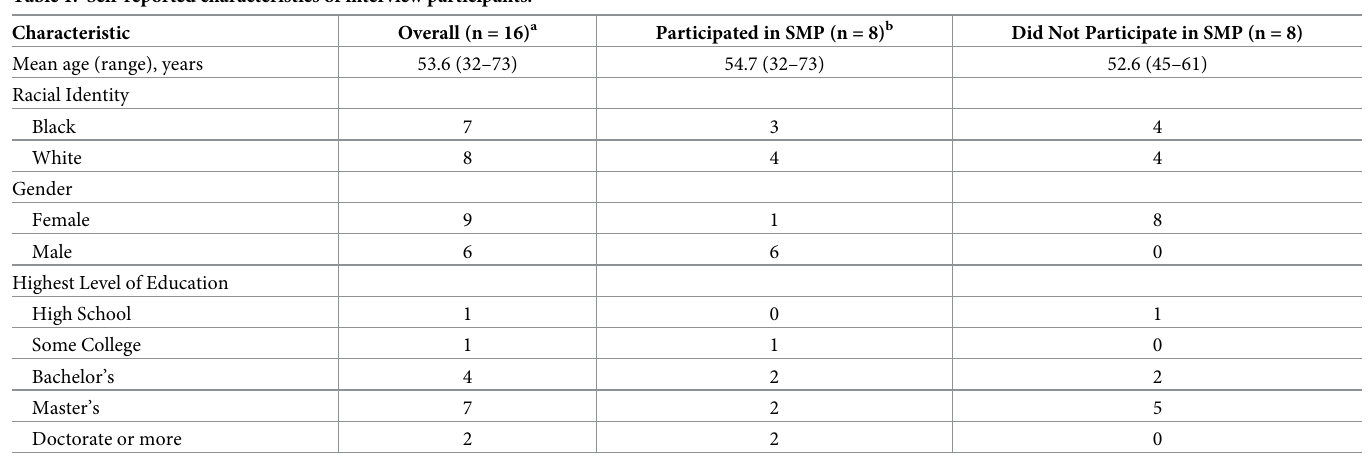
Table 1. Self-reported characteristics of interview